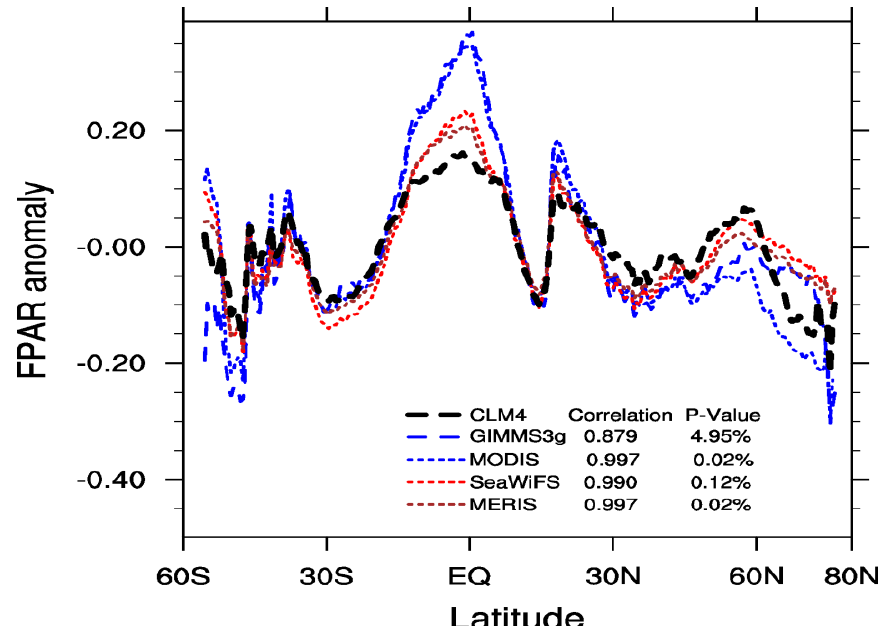
Figure 7. Comparison of zonal mean FPAR between remote sensing observations and CLM4 FPAR averaged from 2003 to 2005. Correlation coefficients ( i.e. , correlation and p -value) are calculated between CLM4 zonal mean FPAR and each satellite FPAR